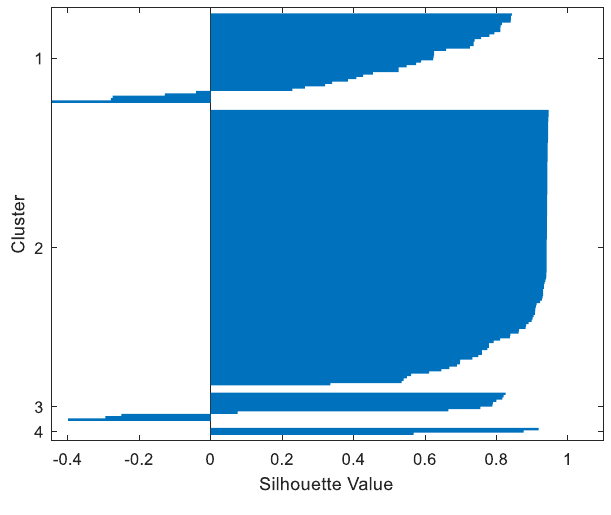
Figure 8. Iris GMM.